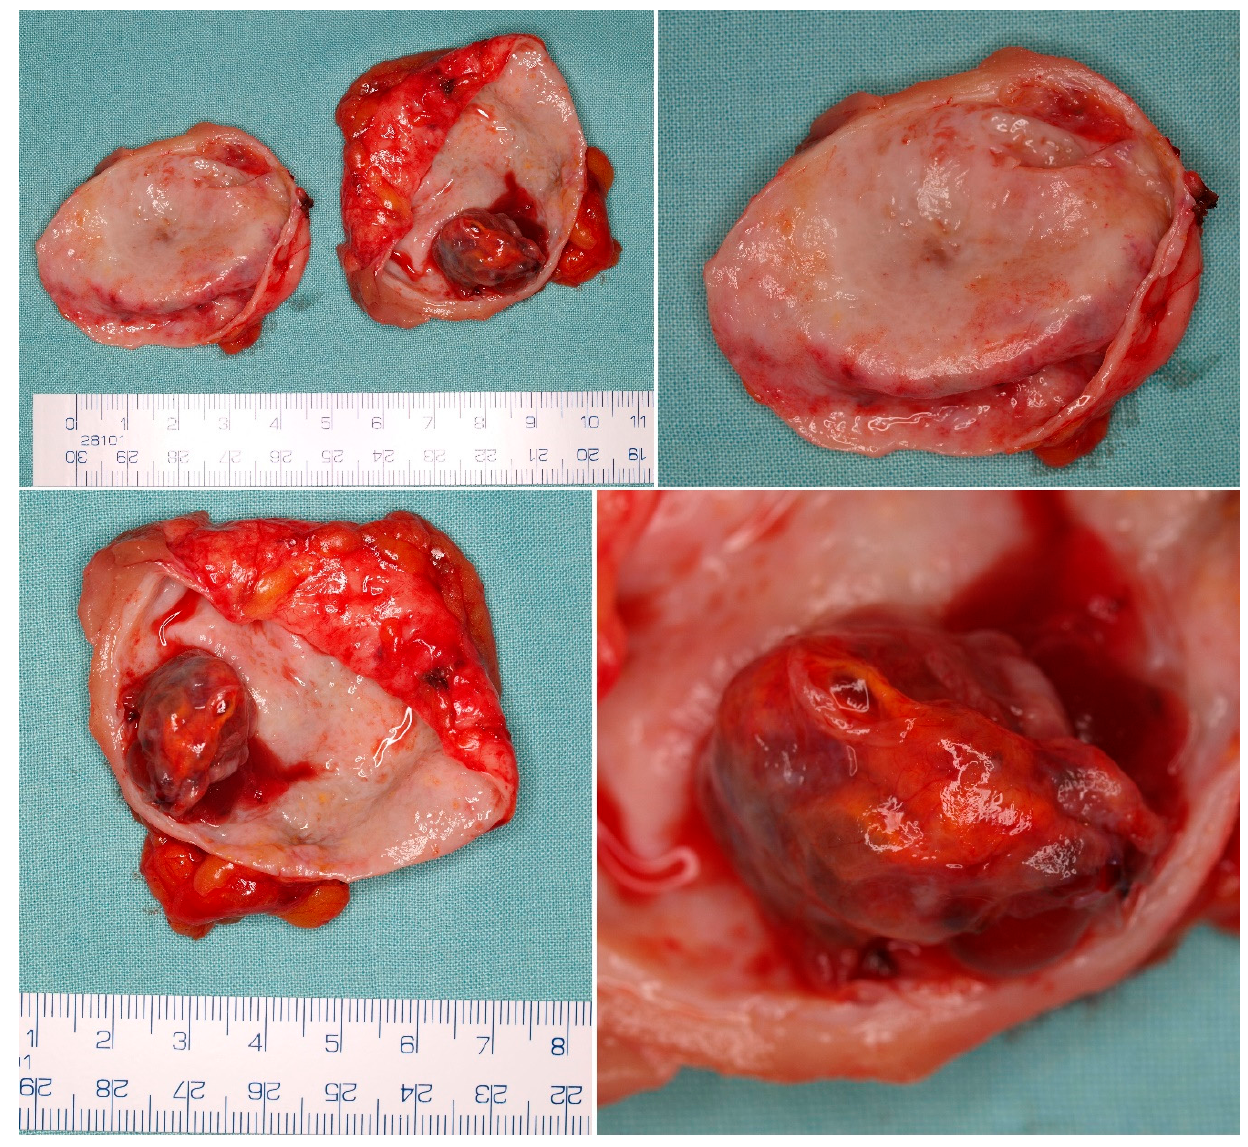
Figure 3. Macroscopic appearance of an MCRNLMP specimen from nephron sparing surgery. The dominant cystic space contains smaller cystic expansion. The absence of solid mass is crucial for the diagnosis of MCRNLMP, and must be proved by microscopic examination of the specimen.